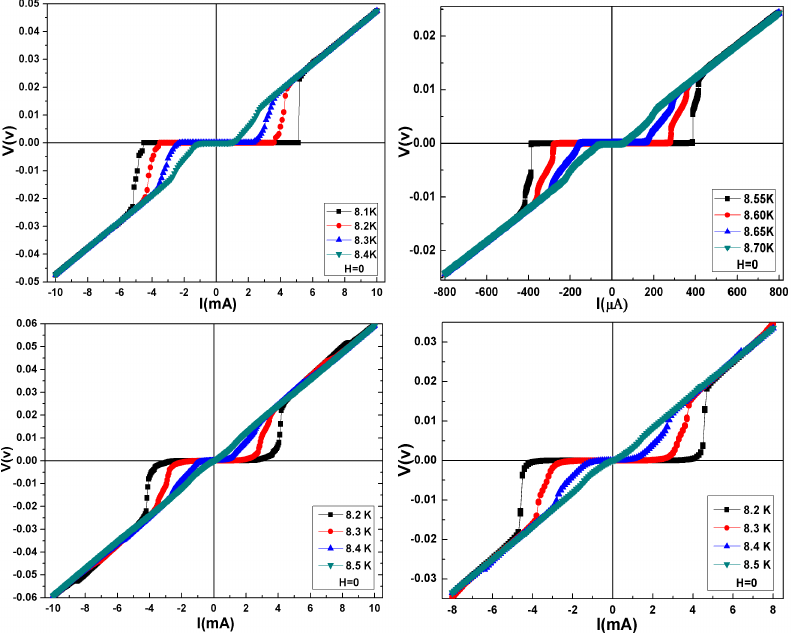
Figure 2. The IV characteristics of four geometries at different temperatures and magnetic fields: top left-right (rectangular-square), bottom left-right